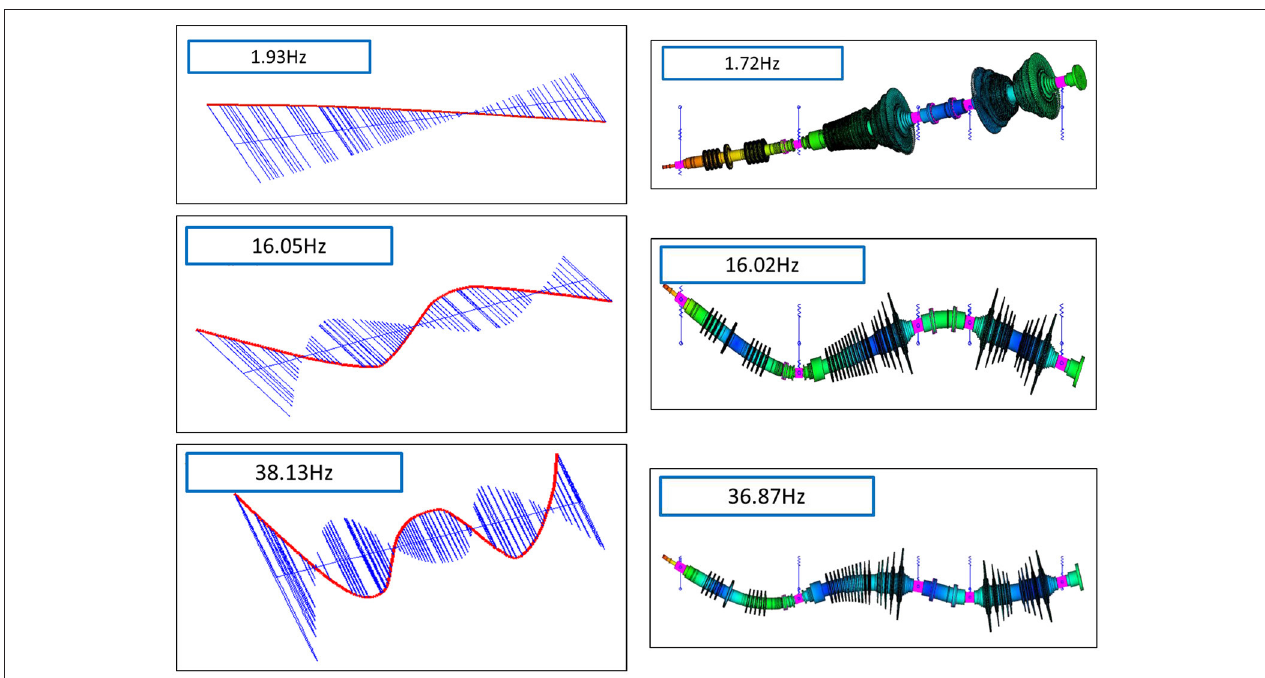
FIGURE 13 | 2nd, 4, and 5th eigenmodes of the simplified FE model at idle state at 1.93, 16.05, and 38.13Hz and equivalent eigenmodes of the full-scale FE model at 1.72, 16.02, and 36.87 Hz.